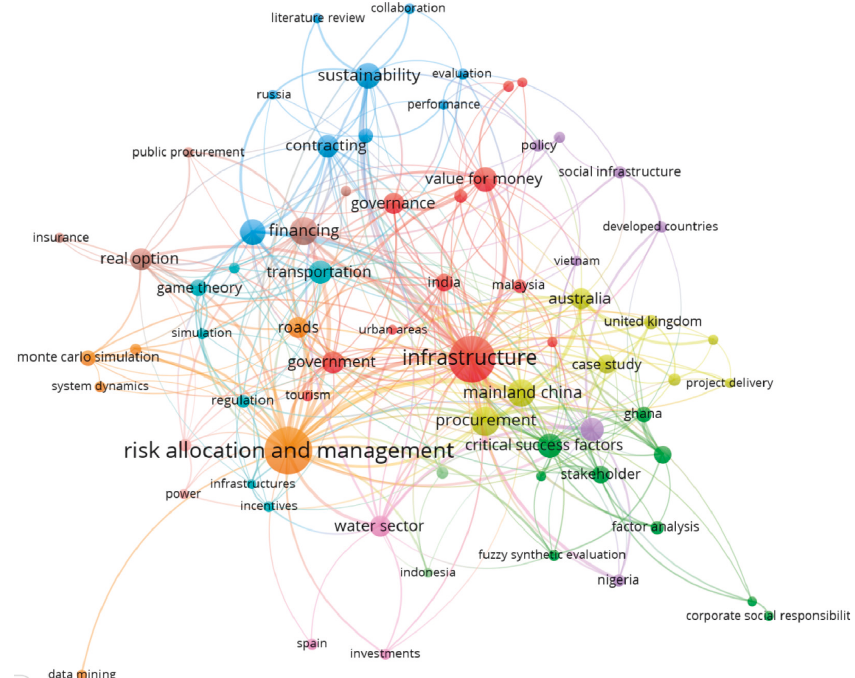
Figure 4: Co-occurrence of